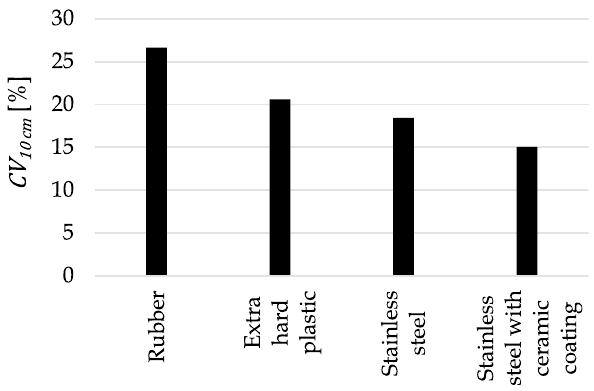
depending on applied false 10 cm